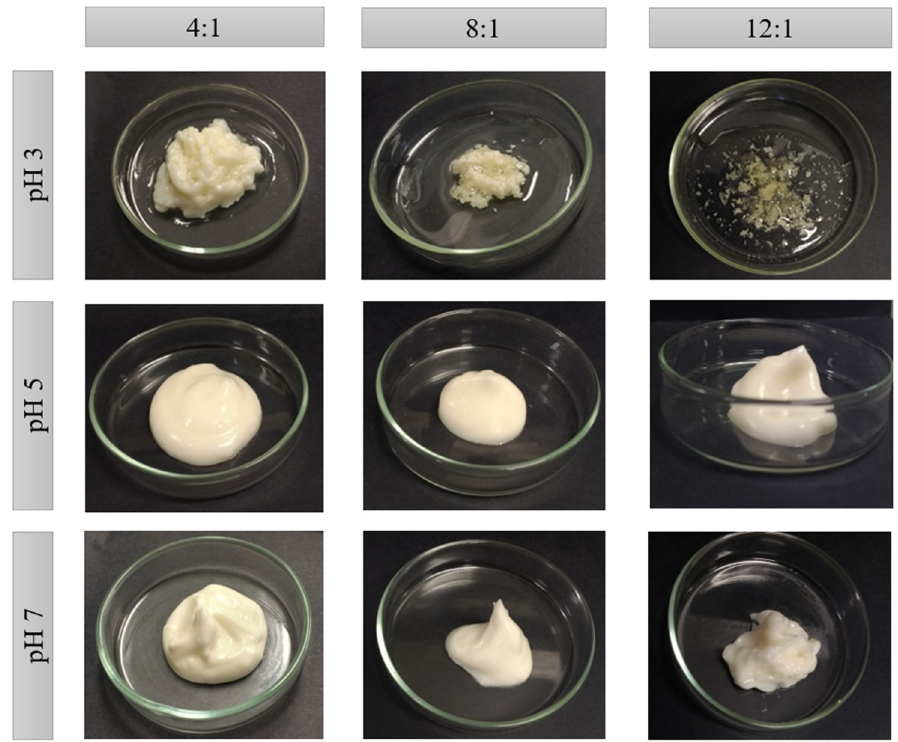
Figure 2. HIPEs macroscopic appearance obtained with pea protein (PP) and xanthan gum (XG) at different PP:XG ratios (4:1, 8:1 and 12:1) and pHs (3, 5 and 7). Table 1. Mass balance of HIPEs after emulsion drying (100 g of initial